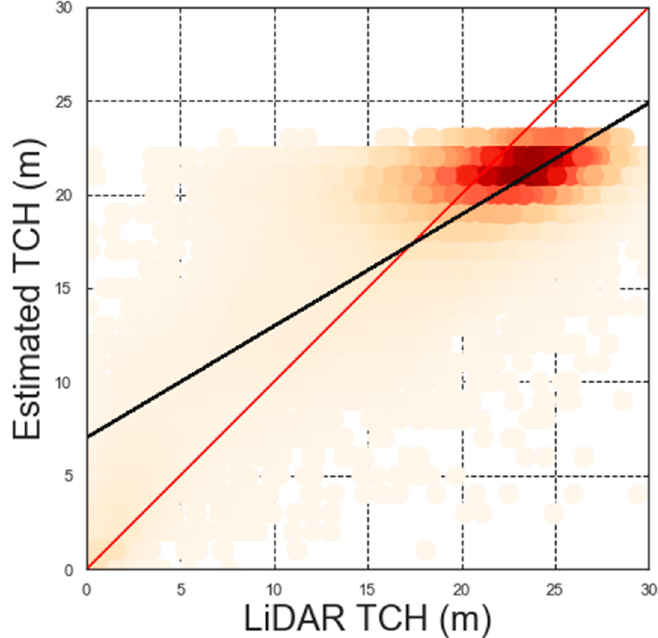
Figure 5. The model produces a country-wide estimation of TCH with R 2 = 0.65 and root mean square error (RMSE) of 4.36 m on 20% LiDAR-based TCH validation samples. Training parameters were 20 Fourier bins, 8 clusters, 6 dimensions, 3000 landmarks, and 600 projection samples. These parameters were chosen to balance learning image artifacts and minimize the RMSE. Note that the estimated TCH values are of the integer type.